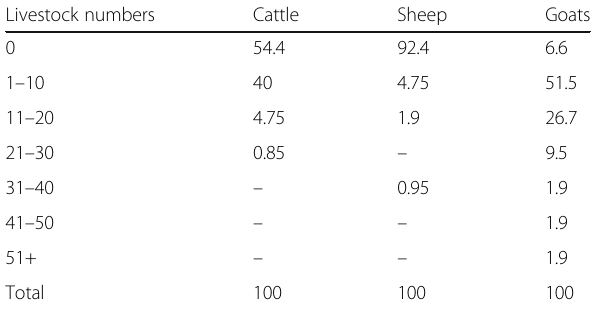
Table 2 Livestock inventory (cattle, sheep and goats) in